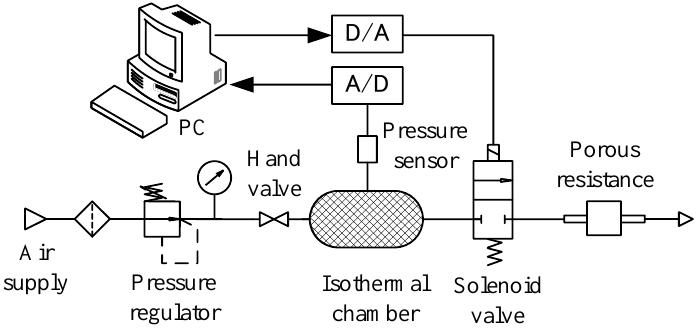
Figure 5. Schematic of the apparatus for discharge method.